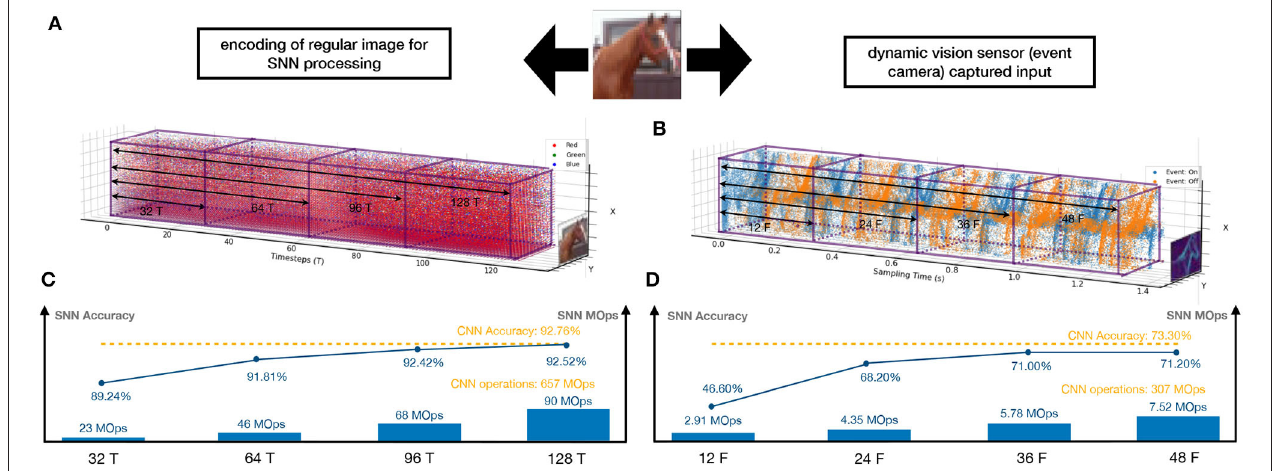
FIGURE 1 | An illustrative diagram showing how SNNs process two different types of inputs and their performance comparison with CNNs. A regular image (left column)—taken from the camera—is preprocessed into a spike train (A) , which then runs through the SNN in several timesteps (e.g., 128 timesteps as in the figure). A DVS input—taken from the event camera—can be represented directly as a spike train (B) , and processed naturally by the SNN in several frames (e.g., 48 frames as in the figure). (C,D) show the SNN’s performance with respect to the three objectives (accuracy, energy efficiency, and latency), compared to